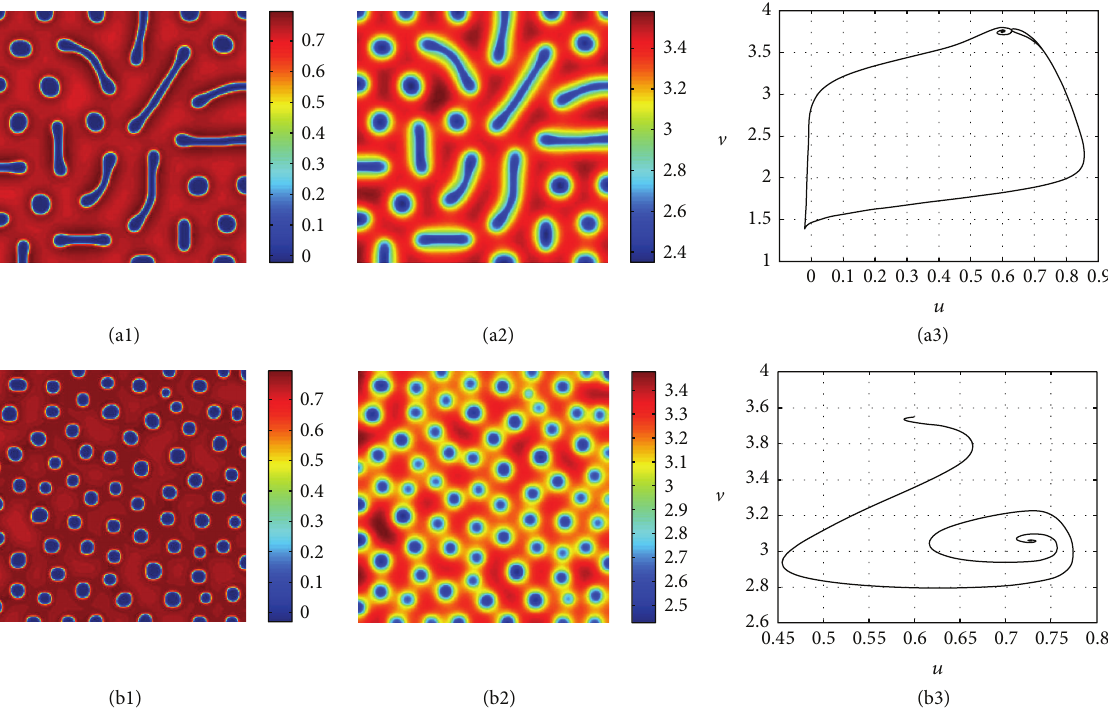
Figure 4: Dynamical behavior of model (5). 𝐷 12 = −0.365 (the first row); 𝐷 12 = −0.5 (the second row); and other parameters are fixed as (27) in the text. (a1), (b1) Two categories of Turing patterns of prey 𝑢 at 𝑡 = 10 000 ; (a2), (b2) two categories of Turing patterns of predator V at 𝑡 = 10000 ; and (a3), (b3) phase portraits.